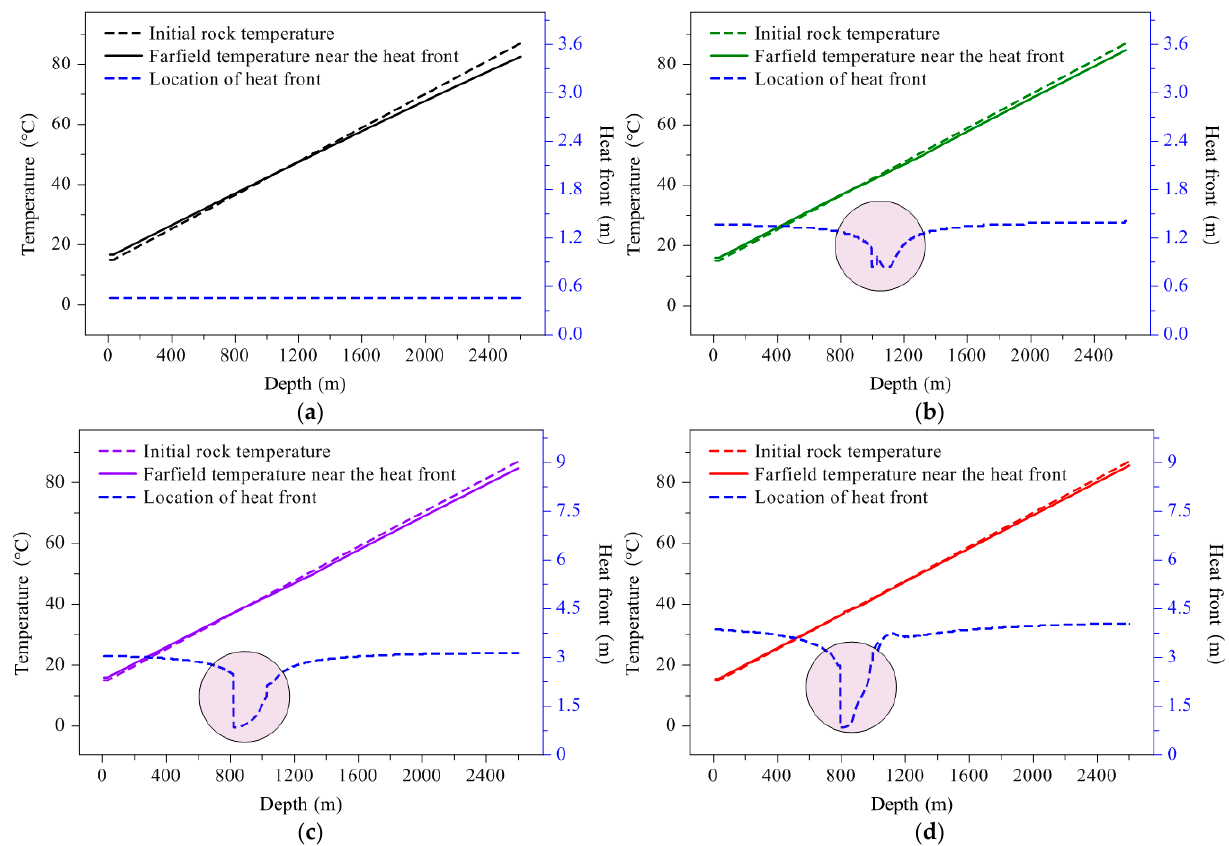
Figure 11. Heat front propagation and radial far field rock temperature (near the boundary of radial heat front) along depth during the low temperature heat storage days ( a )-1 day, ( b )-10 day, ( c )-20 day, ( d )-30 day.